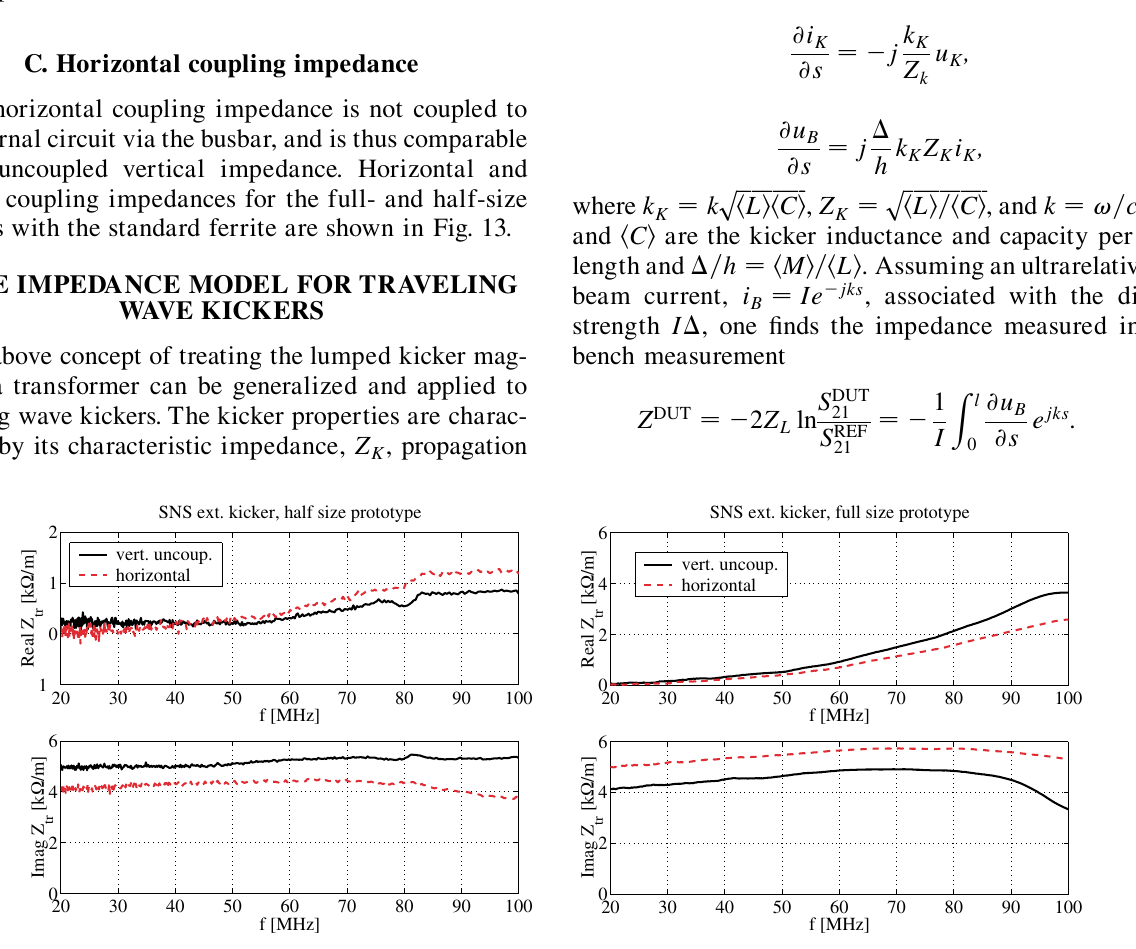
FIG. 13. (Color) Comparison of horizontal and uncoupled vertical impedance of half-size (left panel) and full-size (right panel) magnets.